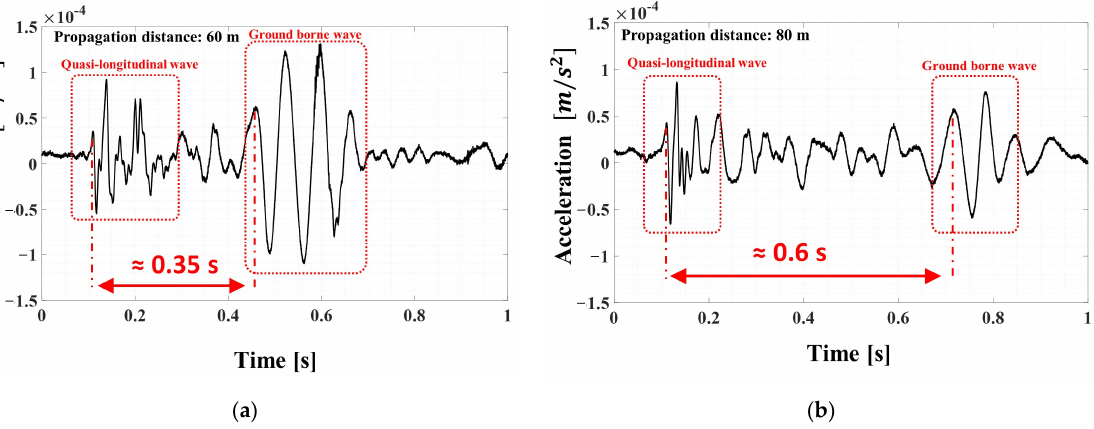
Figure 19. Time-domain signals obtained from each sensor including a ground-borne wave: ( a ) propagation distance of 60 m and ( b ) propagation distance of 80 m. ( a ) propagation distance of 60 m and ( b ) propagation distance of 80